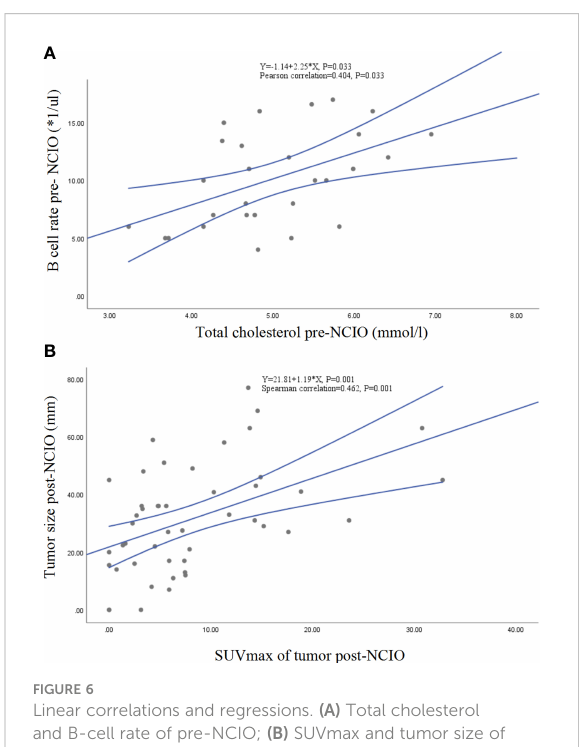
FIGURE 6 Linear correlations and regressions. (A) Total cholesterol and B-cell rate of pre-NCIO; (B) SUVmax and tumor size of post-NCIO. NCIO: neoadjuvant chemoimmunotherapy, SUV, standardized uptake